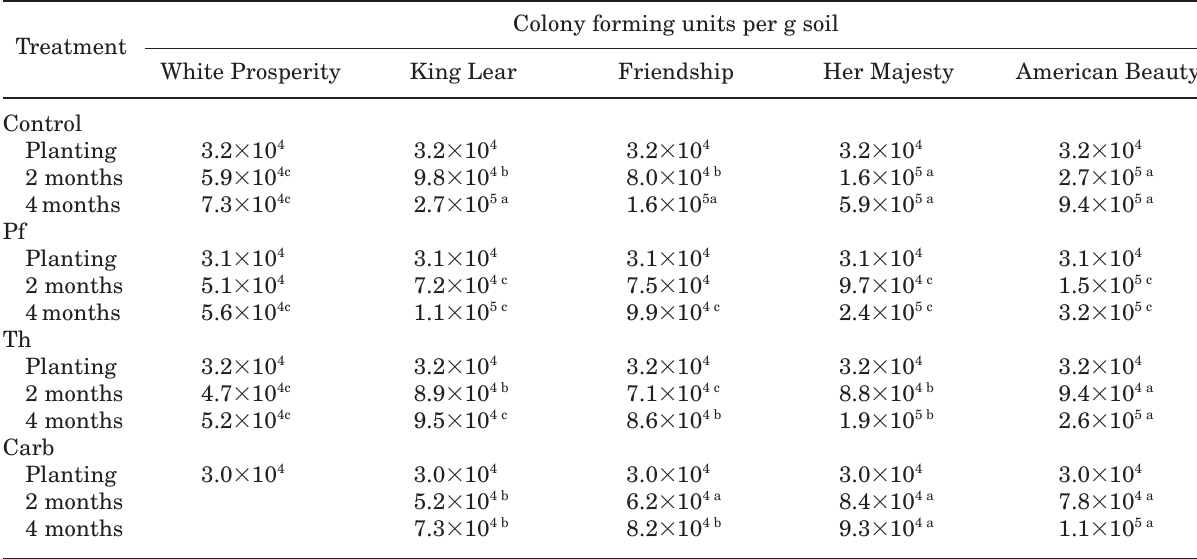
Table 4. Populations of Fusarium oxysporum f. sp . gladioli (Fog) in relation to application of Trichoderma har- zianum (Th) , Pseudomonas fluorescens (Pf) or carbendazim (Carb) in the rhizosphere of gladiolus cultivars